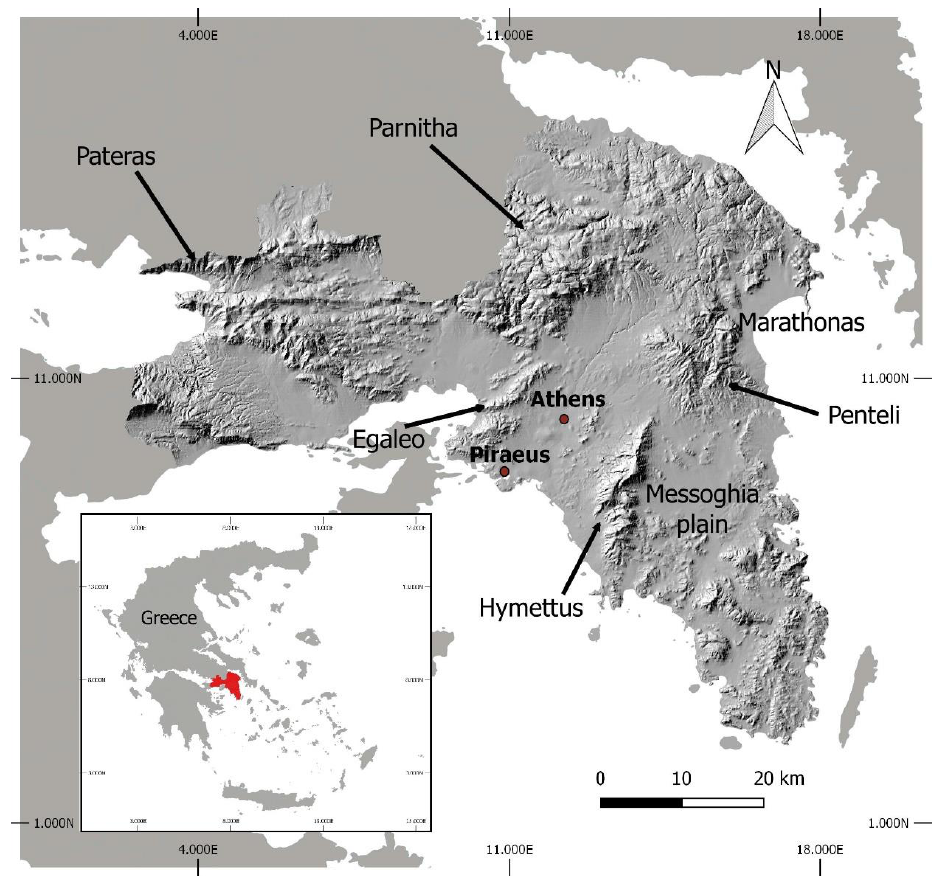
Figure 1. Location and topography of the Attica region.